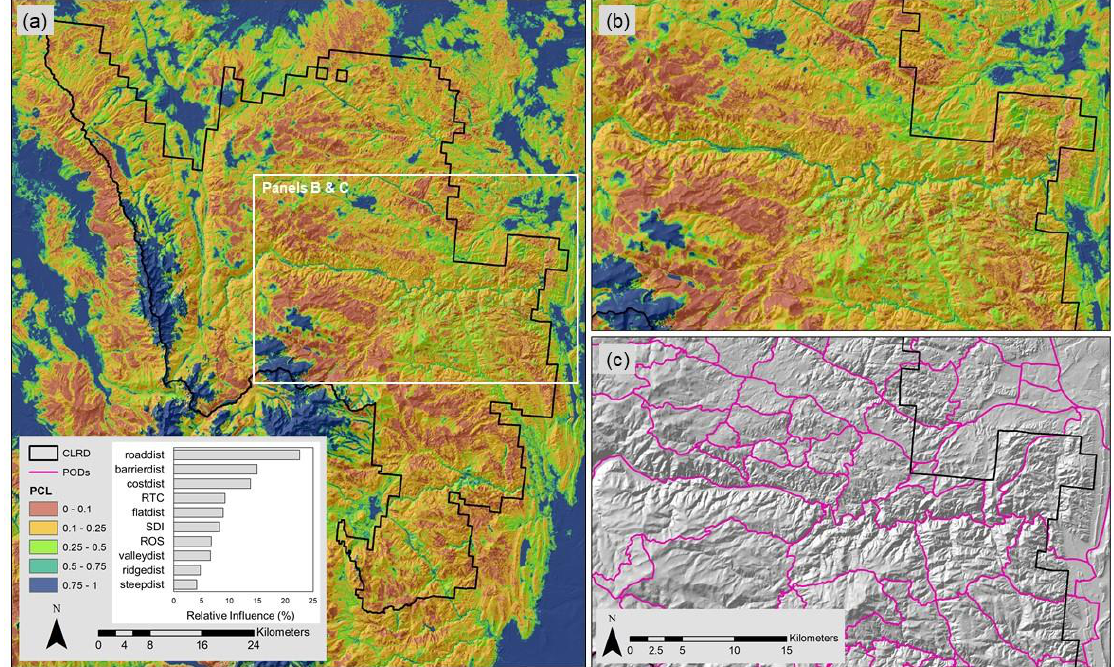
Figure 4. Potential Control Location (PCL) raster generated to support potential wildland fire operational delineation (POD) development for the Canyon Lakes Ranger District (CLRD) of the Arapaho-Roosevelt National Forest in Northern Colorado. Panel ( a ) indicates the locations of the other panels on the landscape and depicts a bar chart with the relative influence of final predictor variables in the boosted regression tree model. Panels ( b , c ) show with greater detail how areas of low PCL (top) tend to align with manager-selected POD boundaries (bottom). Panels ( b , c ) also show how POD boundaries span administrative CLRD boundaries.